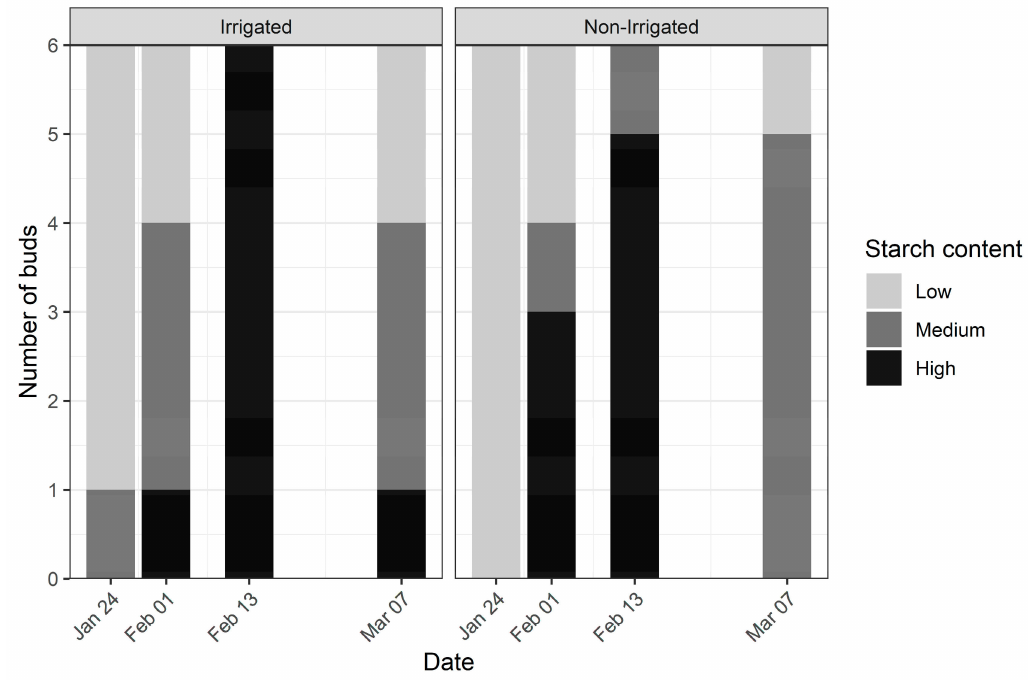
Figure 5. Frequency of buds in a given starch content class (low, medium, or high) according to qualitative observations on flower primordia tissue (see Section 2.6. in Materials and Methods). Samples were taken from shoots and spurs of apple trees cv. ‘Elstar’ grown in Campus Klein-Altendorf exposed to two irrigation regimes (‘irrigated’ and ‘non-irrigated’ panels) during the summer of 2018. For the figure, we used all analyzed buds (48) collected on four dates during the winter of